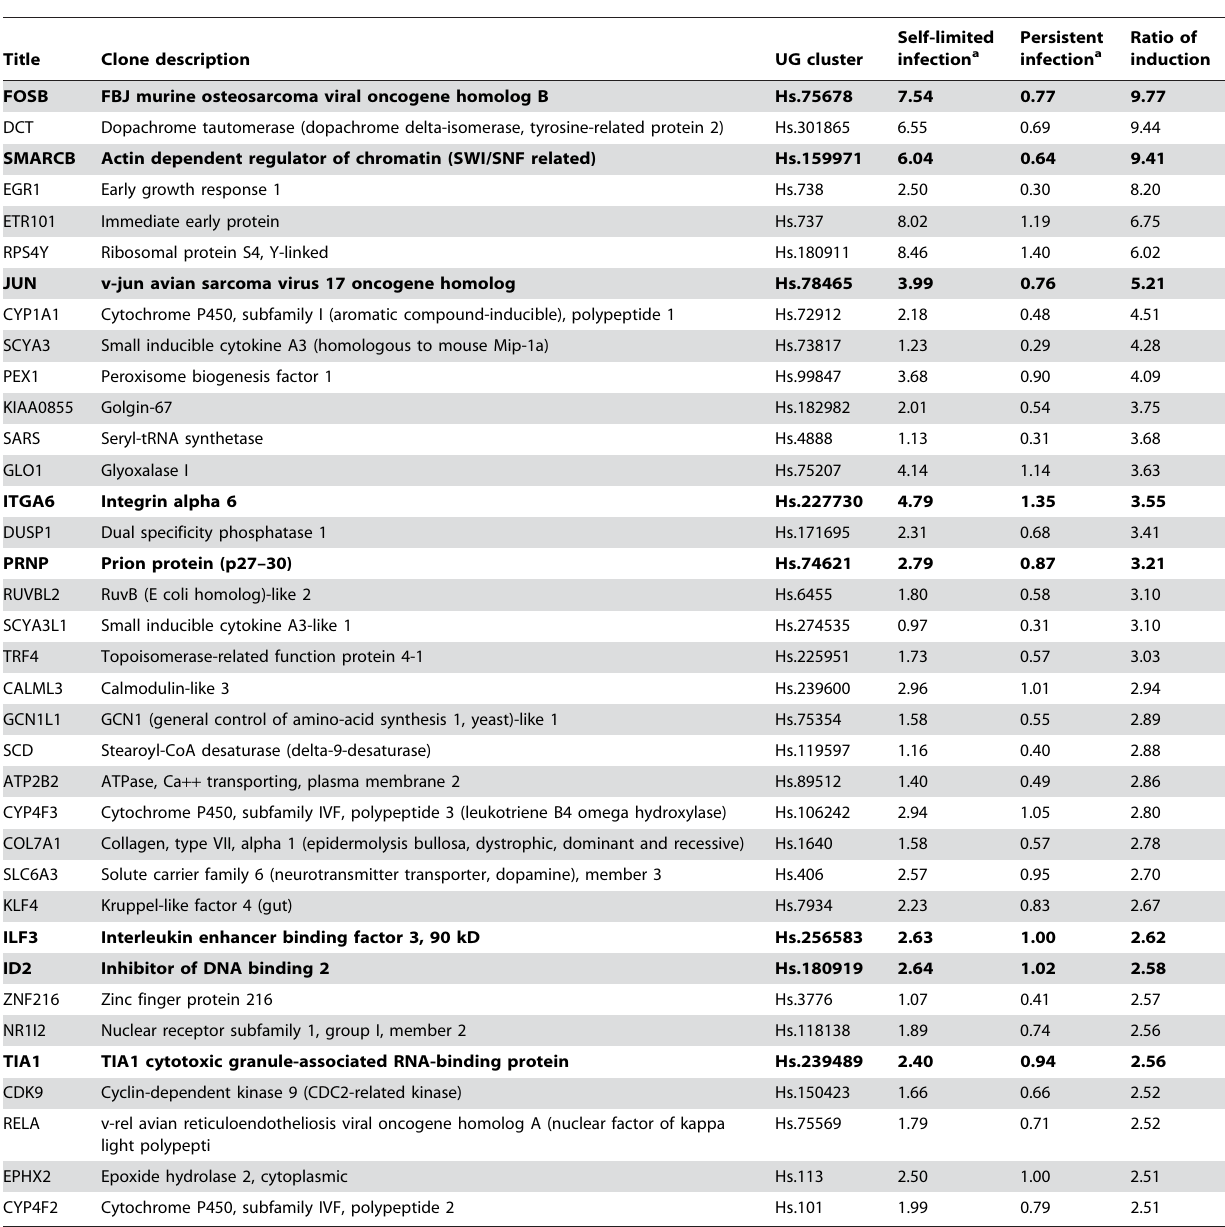
Table 2. Genes induced during the early phase of self-limited infection as defined by average expression